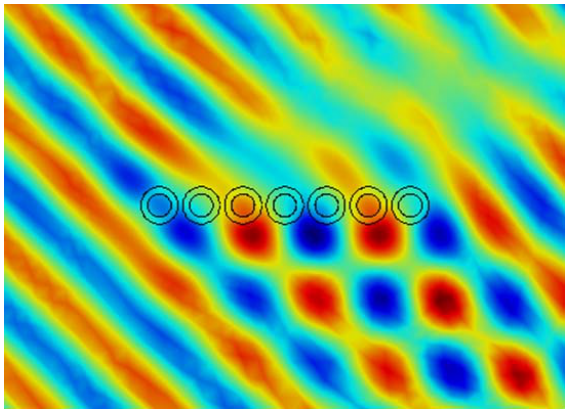
Figure 5. Hydrodynamic interactions within the array.